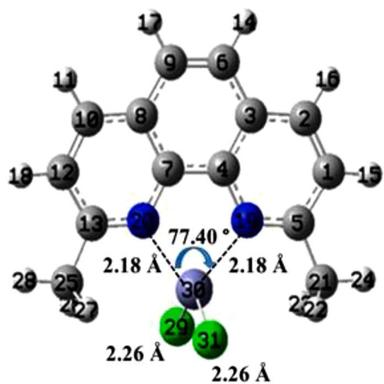
The ground state optimized geometry of the complex.